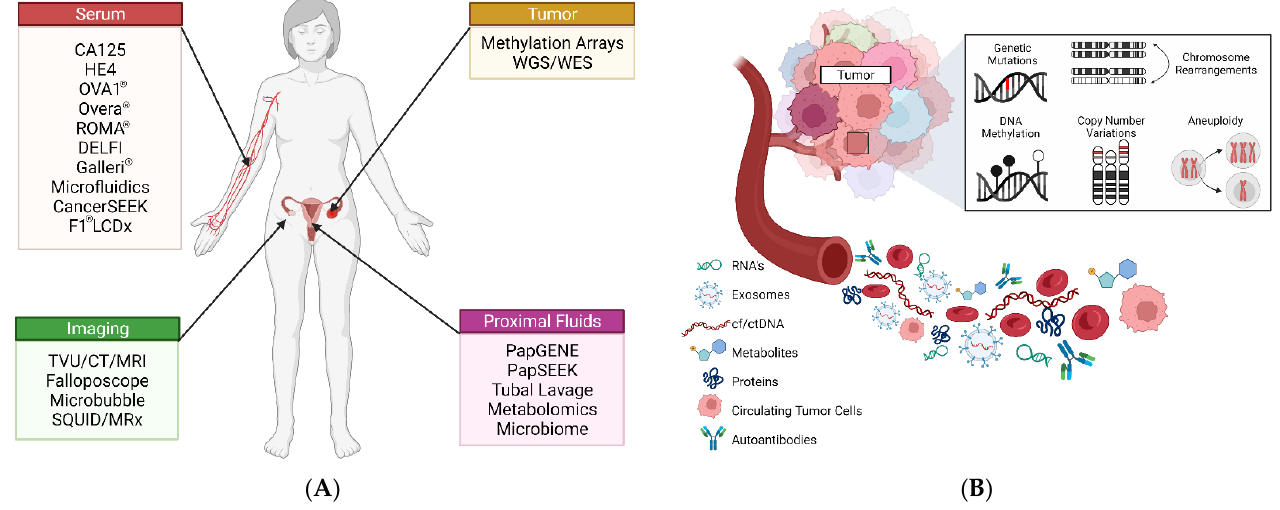
Figure 1. Overview of ovarian cancer screening and diagnostics. ( A ) Relevant emerging strategies for screening and detection of HGSC. ( B ) Circulating tumor biomarkers that can be assayed for screening and diagnostic purposes.